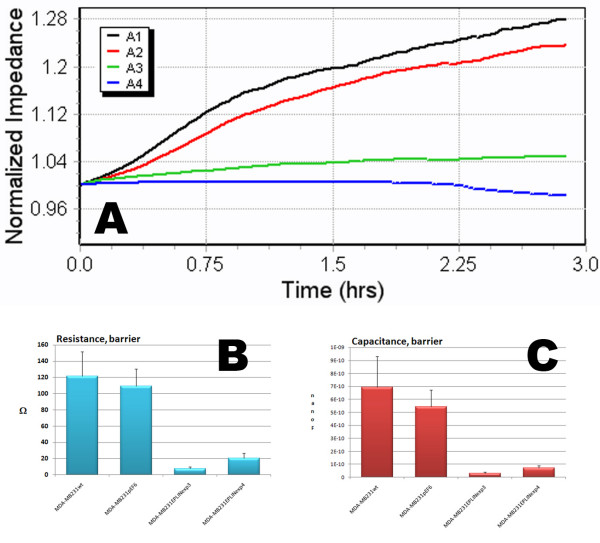
EPLIN-α expression on cell migration as analysed by ECIS. A: wounding assays. Cells were first wounded at 6 v for 30 sec. The impedance change was shown. Electrode – A1: MDA-MB231wt, A2: MDA-MB231pEF/His, A3: MDA-MB231EPLINexp3, A4: MDA-MB231EPLINexp4. The breast cancer cells which over-expressed EPLIN-α showed a markedly reduced migration. B and C: ECIS RbA modelling of cell motility indicated a significant reduction of motility in EPLIN-α transfected cells as shown by resistance in B and capacitance in C. * p < 0.01 vs MDA-MB231wt and MDA-MB231pEF/His.